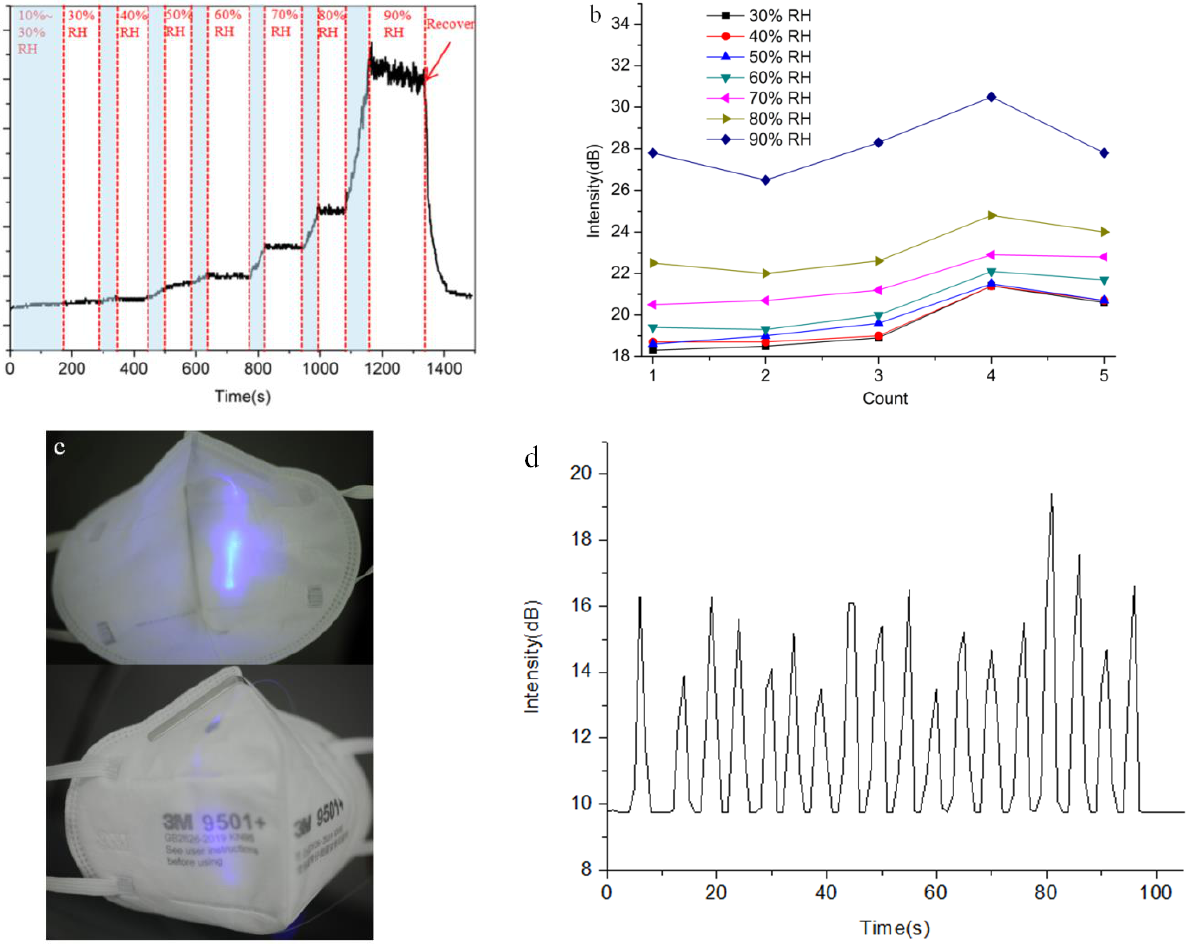
Figure 4. Characterization of the SOFS for humidity sensing. ( a ) Continuous humidity test ranging from 10% to 90% RH; the light blue area is the process of increasing the humidity. ( b ) Fluctuation in the intensity response at every humidity stage corresponding to five repeated measurements. ( c ) Photograph of a home-made breath-monitoring mask. ( d ) Real-time measurement of the respiration of a volunteer under deep breath (12 min −1 ) conditions.